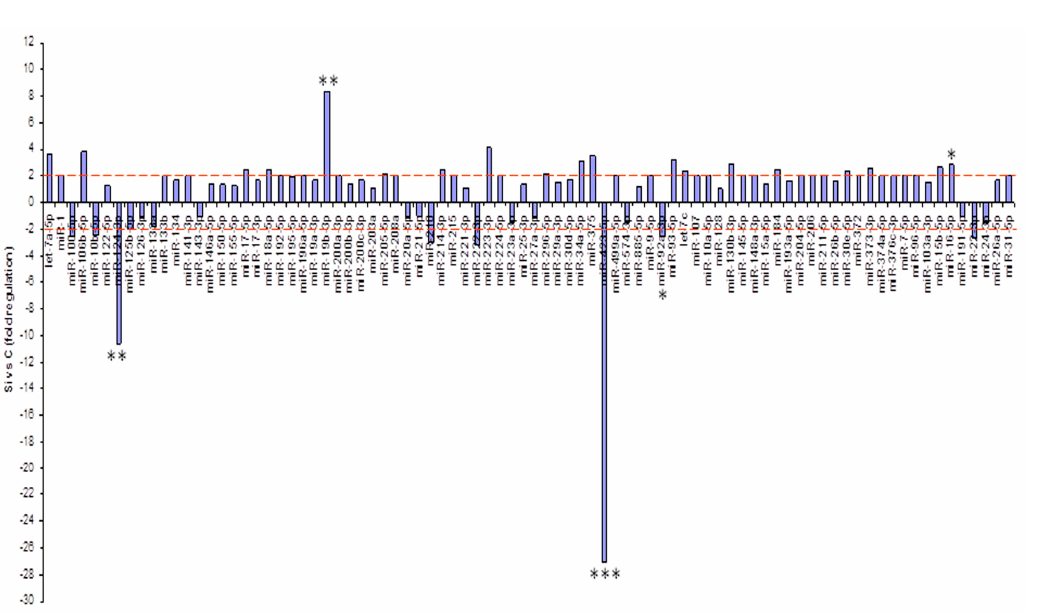
Figure 5. miRNA profiling. Fold regulation of miRNA levels detectable in the medium of silybin- treated cells versus untreated cells. p -values of the Student’s t -test were * p < 0.05, ** p < 0.01, or *** p < 0.001.